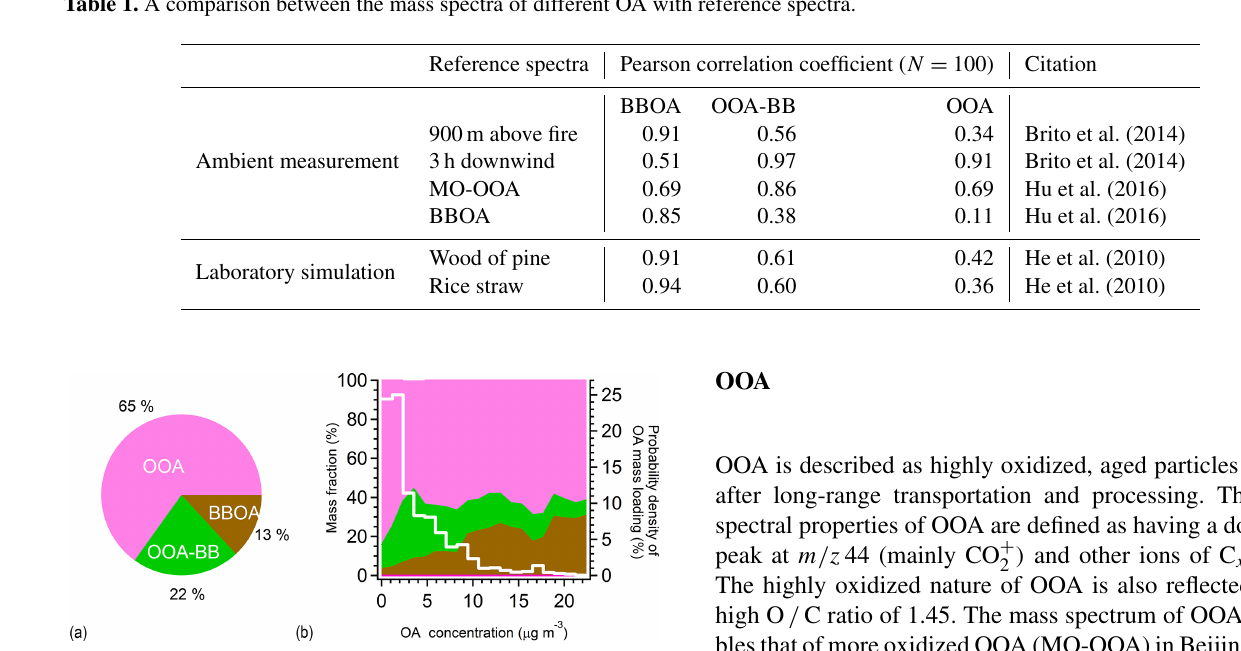
Figure 6. The (a) contribution of each factor to the total OA mass and the (b) fractions of OA factor (left axis) and the probability density of OA concentration (white line, right axis) as a function of OA mass